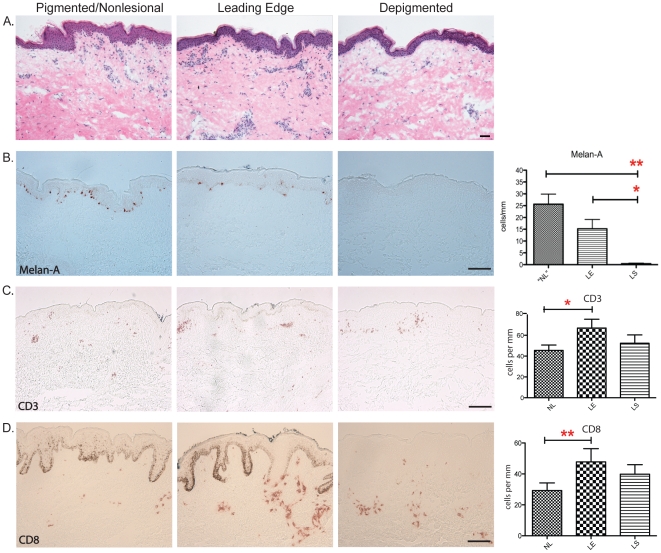
T cell infiltration and loss of melanocytes in lesional and leading
edge vitiligo skin.(A) Hematoxylin and eosin staining of non-lesional, leading edge and
depigmented vitiligo skin does not reveal any abnormality, but
significant immune cell infiltrations were found in the dermal regions
of leading edge vitiligo biopsies. Bar = 100 mm.
(B) Immunohistochemical staining of Melan-A on non-lesional, leading
edge and depigmented vitiligo skin. The staining pattern of Melan-A is
consistent with the degree of depigmentation in our vitiligo biopsies.
Bar = 100 mm. Bar charts to the right of (B) is
cell count of Melan-A positive cells of non-lesional, depigmented
lesional and leading edge skin in biopsies of vitiligo patients.
Non-lesional vitiligo skin has significantly higher number of
melanocytes than lesional (p<0.0027) and leading edge skin
(p<0.0082). Leading edge has significantly higher numbers of Melan-A
positive cells than lesional vitiligo skin (C) Immunohistochemical
staining of CD3+ T cells at non-lesional, leading edge and
depigmented lesional vitiligo skin. (D) Immunohistochemical staining of
CD8+ T cells at non-lesional, leading edge and depigmented lesional
vitiligo skin. Bar = 100 mm, applies to both
C&D. T cell infiltrates are predominantly found at the
dermal-epidermal junctions in the leading edge vitiligo skin. Bar charts
on the right to C&D provide the numbers from quantitative cell
counting of CD3+ and CD8+ T cells, respectively.